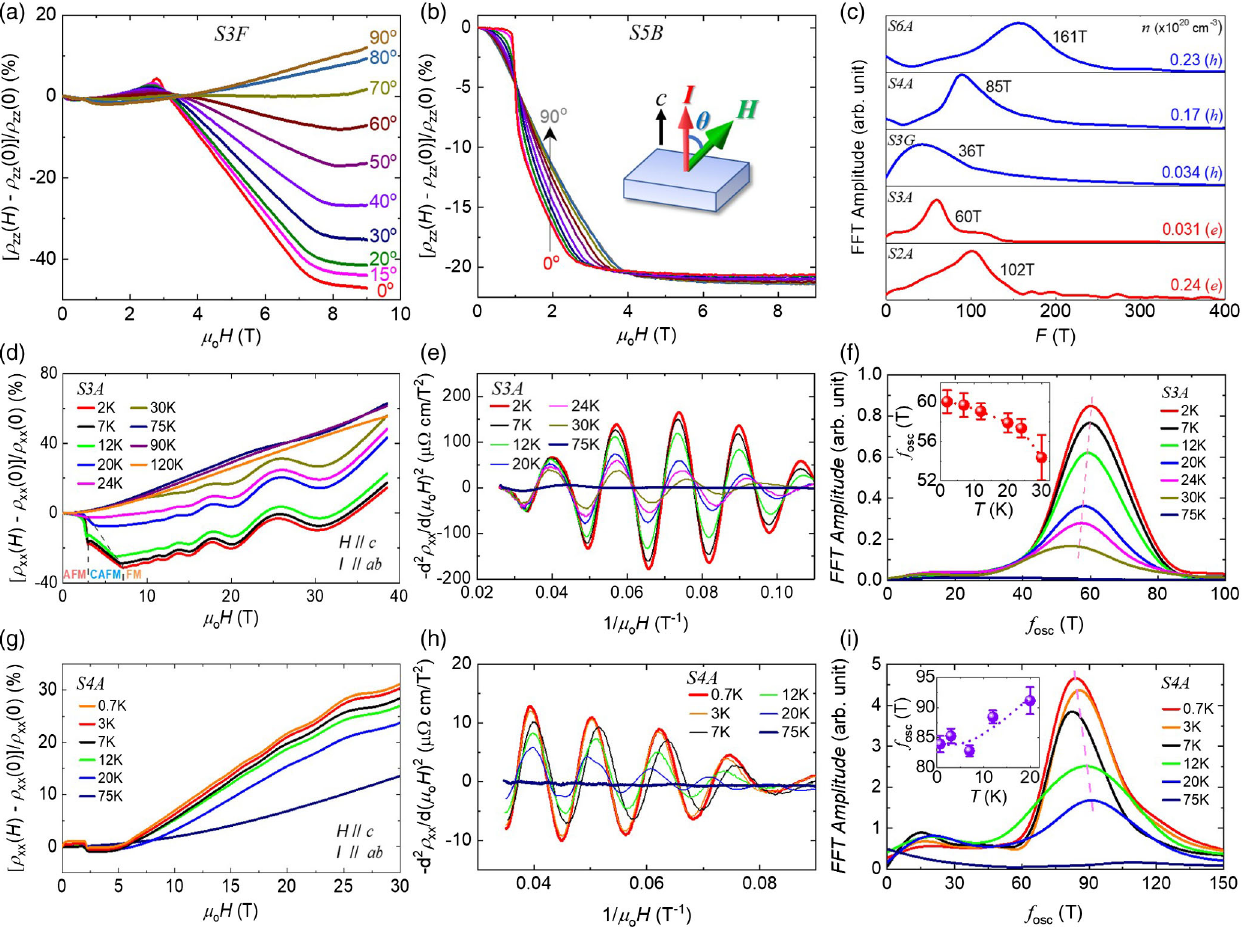
FIG. 5. Magnetoresistivity and SdH oscillations in Mn ð Bi 1 − x Sb x Þ 2 Te 4 . (a),(b) The c -axis magnetoresistivity MR ¼ ½ ρ zz ð H Þ − ρ 0 Þ(cid:2) = ρ 0 Þ under various field orientations for (a) the lightly ( S3F ) and (b) heavily hole-doped ( S5B ) samples. The schematic in zz ð zz ð H Þ 2 for (b) illustrates the experimental setup for the c -axis MR angular dependence measurements. (c) FFT spectra of − d 2 ρ xx =d ð μ o various moderately and lightly electron- and hole-doped samples [see Supplemental Material, Fig. S5(a) [48], for the SdH oscillations]. (d),(g) In-plane transverse MR of samples (d) S3A and (g) S4A at various temperatures. (e),(h) The second derivative of the in-plane resistivity ρ xx ð H Þ with respect to field H (perpendicular to the plane) for samples (e) S3A and (h) S4A as a function of the inverse of the field at various temperatures. (f),(i) FFT spectra of the second derivative of ρ xx ð H Þ for samples (f) S3A and (i) S4A at various temperatures. The insets in both (f) and (i) show the oscillation frequency ( f ) as a function of the temperature for samples S3A and osc S4A , respectively. The error bar shown in the insets in (f) and (i) is defined as the difference of the oscillation frequencies obtained from H Þ 2 and Δ ρ H Þ [the oscillatory component of ρ H Þ ], respectively. All the measurements shown in the FFT spectra of − d 2 ρ xx =d ð μ xx ð xx ð o (c), (d), and (g) are conducted with the currents applied along the ab plane and the magnetic fields perpendicular to the